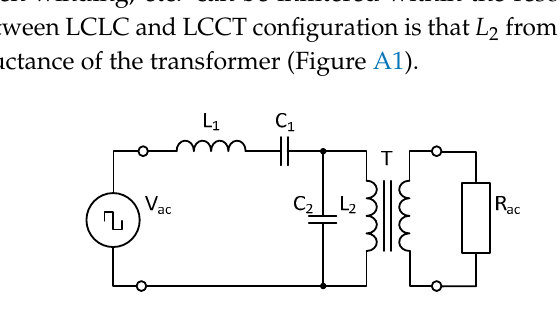
Figure A1. A Numerical solution using the state-variable Figure A1. Simplified equivalent circuit of resonant tank for LCCT converter.